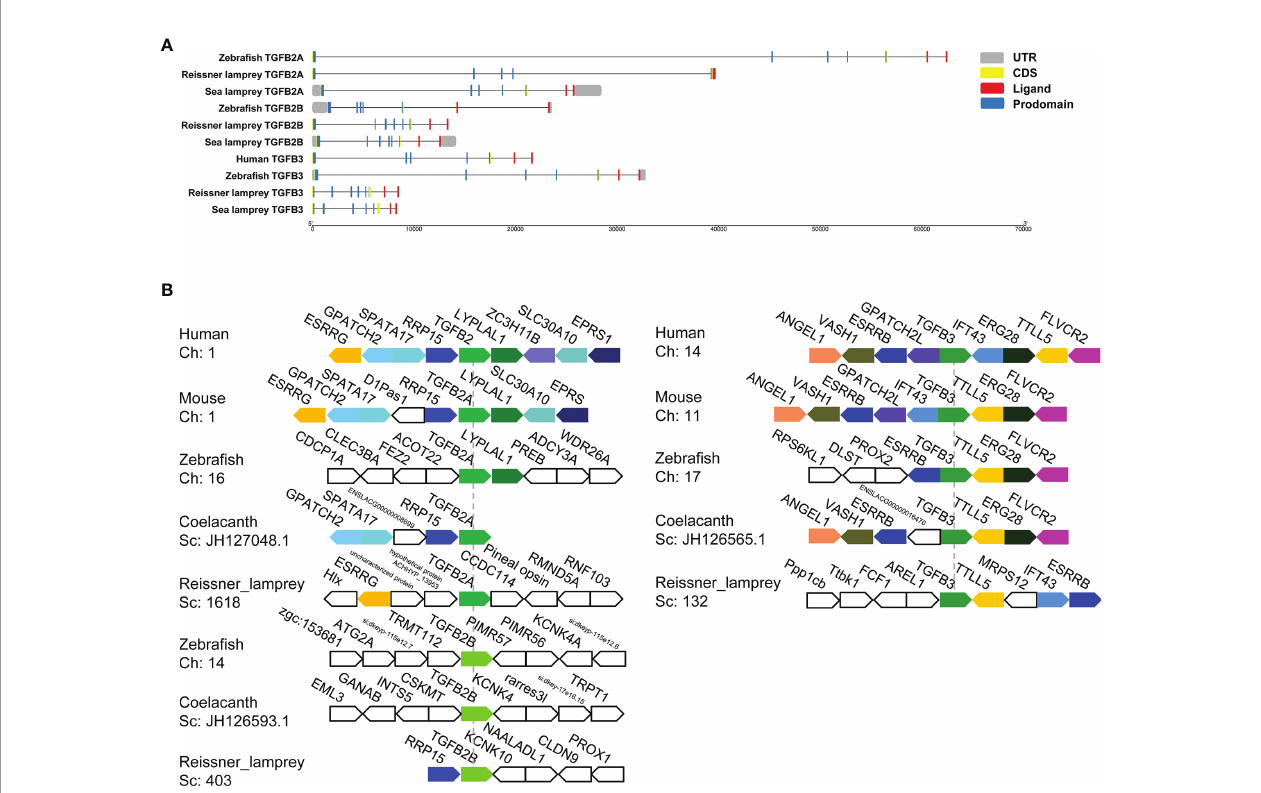
FIGURE 3 | Gene structures and syntenic relationships of TGF- b 2A/2B and TGF- b 3 in the reissner lamprey, bony fi shes, and mammals. (A) The structure of TGF- b 2A/2B and TGF- b 3 genes of different species. Gene lengths are plotted according to the scale at the bottom. The 5 ’ and 3 ’ untranslated regions are represented by grey boxes. Exons are represented by yellow boxes, and introns are represented by straight lines. In each protein-coding sequence, the part encoding prodomain is further marked in blue, while the part encoding ligand is marked in red. (B) The syntenic relationship analyses for comparing the neighboring gene environments of TGF- b 2A/2B and TGF- b 3 in different species. Human TGF- b 2 and TGF- b 3 were used as reference genes, respectively, and the adjacent genes of TGF- b conserved in humans and other species were labeled with different colored polygons. Ch: Chromosome No., Sc: Scaffold No., opposite polygons represent genes on opposite strands. The accession numbers of TGF- b genes in different species retrieved from Genomicus are listed in Supplementary Table 2